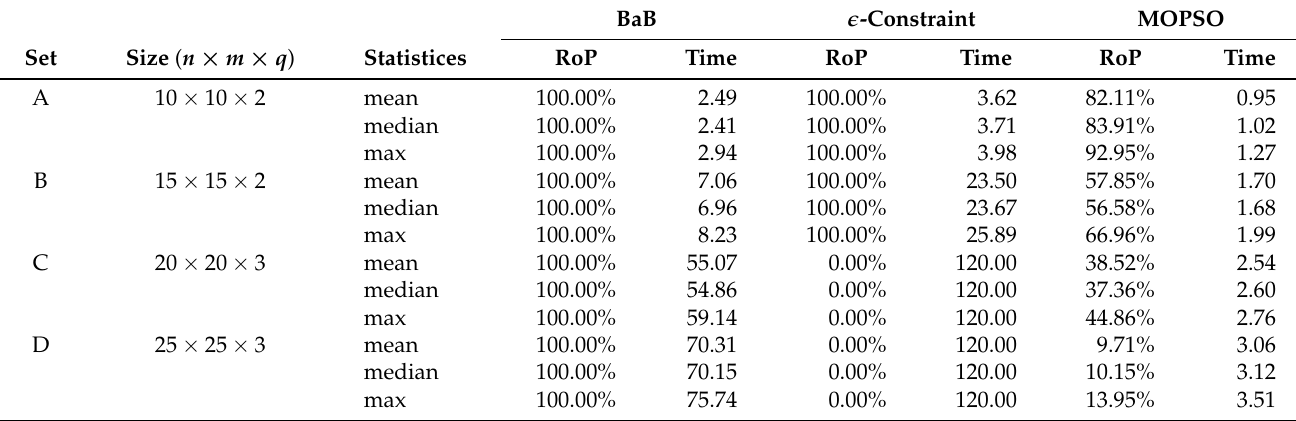
Table 5. Comparisons among three methods from RoP and computation times (minutes). BaB (cid:101) -Constraint